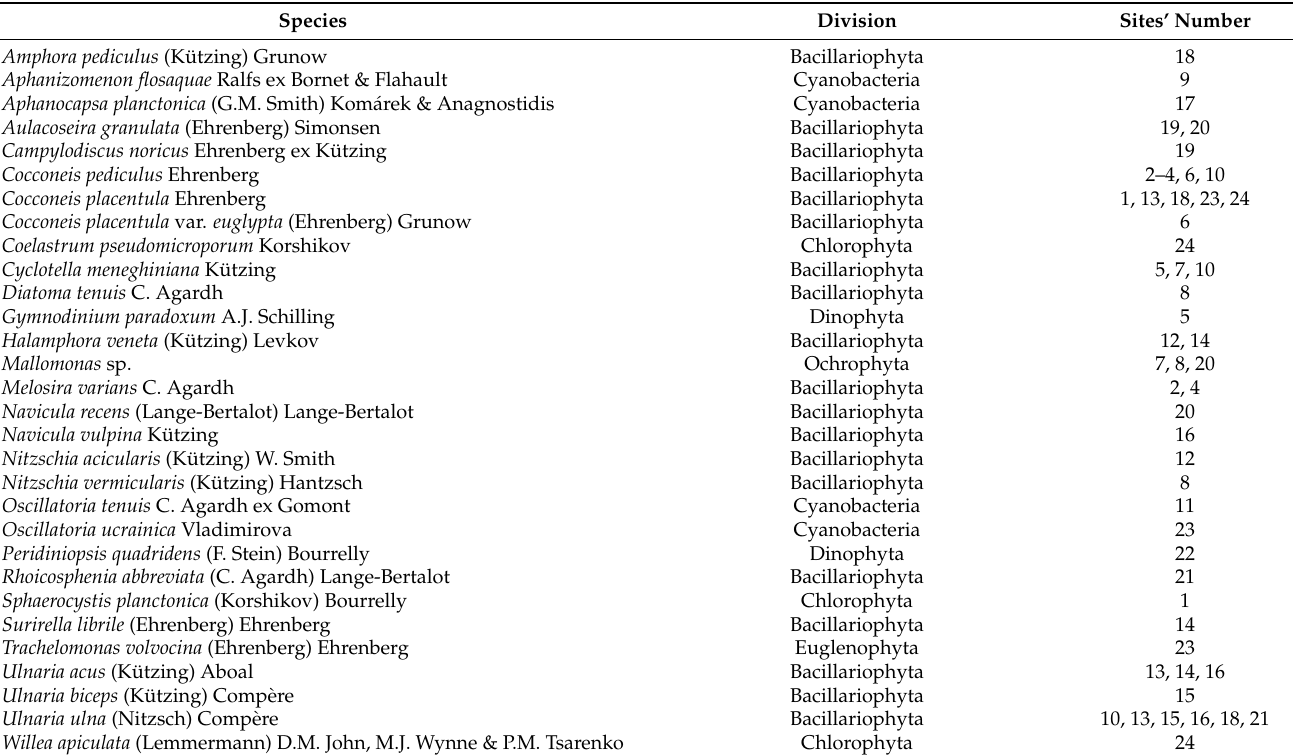
Table 5. Dominant species of algae according to biomass values in the Siversky Donets river basin.